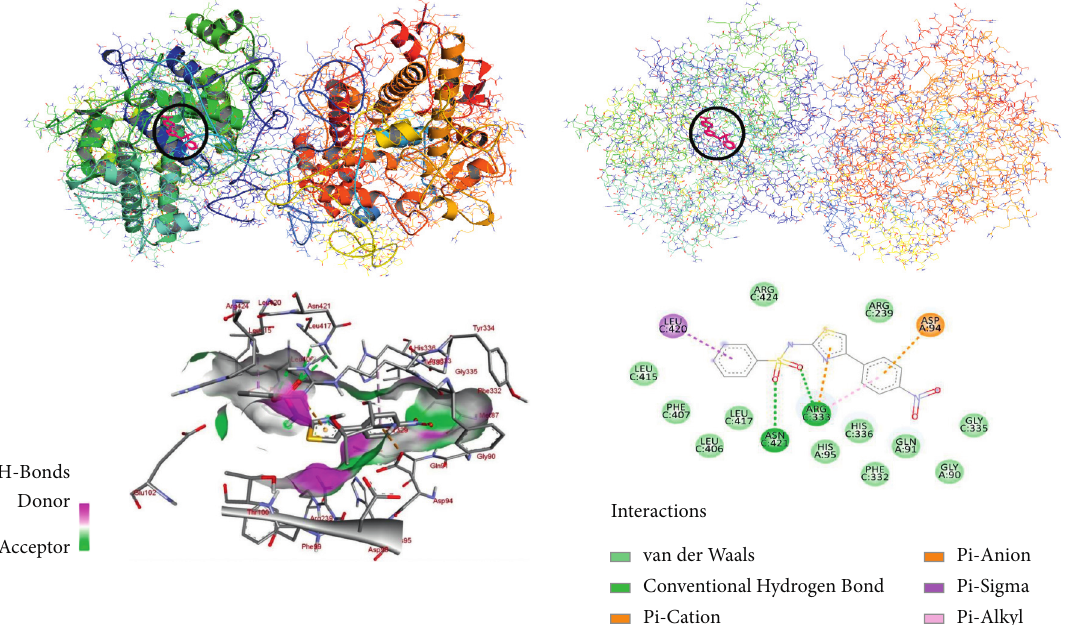
Figure 6: The 2D and 3D binding interactions of compound 11b against human myeloperoxidase (PDB ID:1DNU). 3D ribbon and line models show the binding pocket structure of human myeloperoxidase with compound 11b . Hydrogen bonds between compounds and amino acids are shown as green dashed lines, and hydrophobic interactions are shown as pink/purple lines. Electrostatic interactions are shown as orange